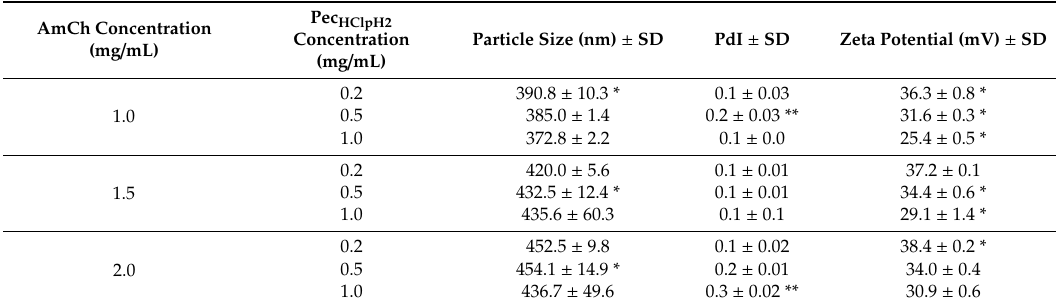
Table 5. E ff ect of the polymer concentration (AmCh and Pec HClpH2 ) on the particle size, PdI and zeta potential of the polyelectrolyte